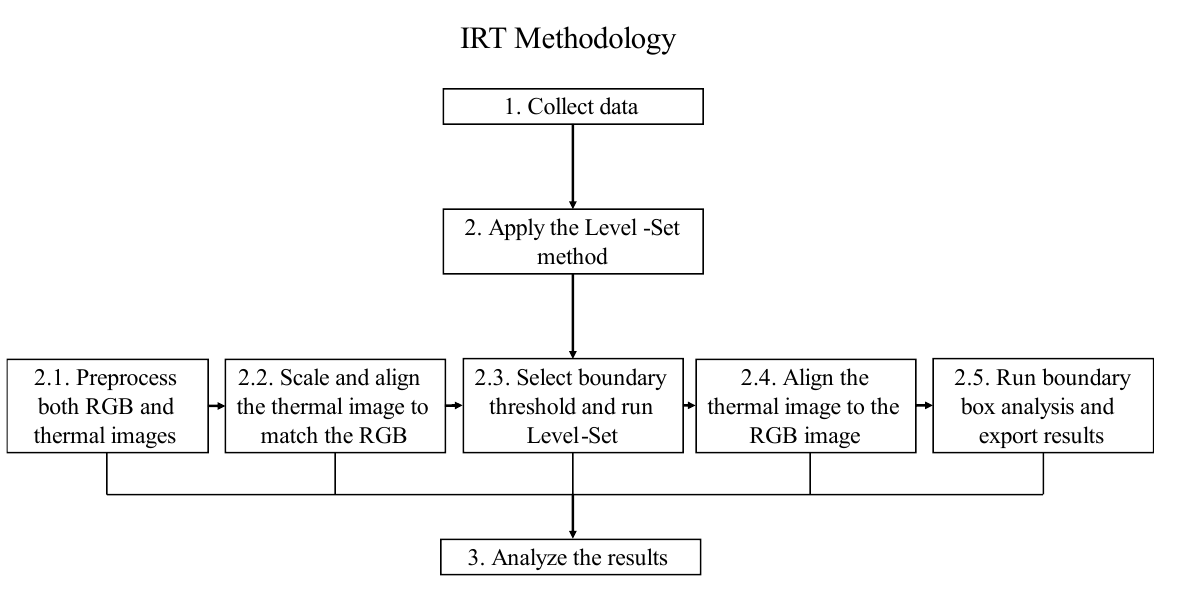
Figure 3. Level-set method application framework.